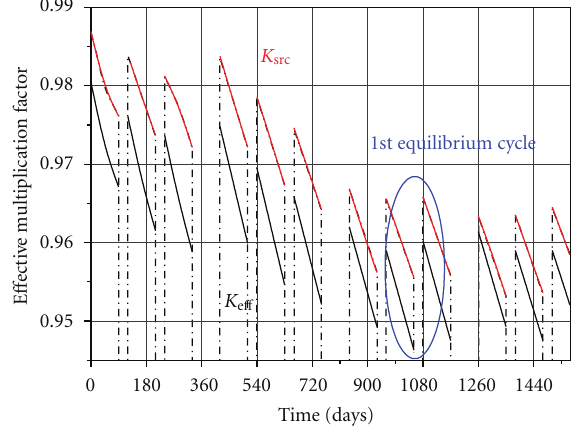
Figure 4: Evolution of e ff ective neutron multiplication factor K e ff and external source neutron multiplication factor K src .